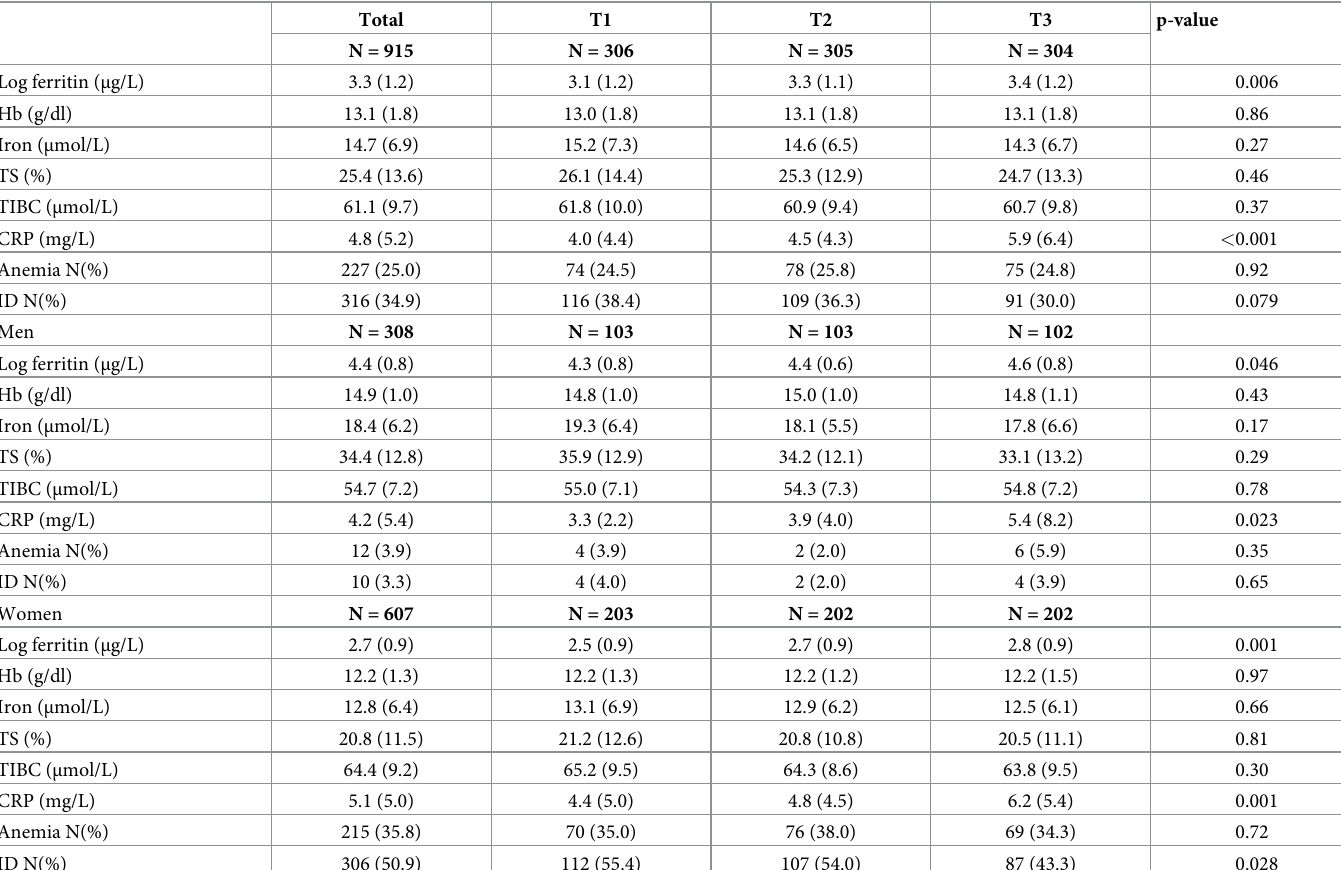
Table 3. Comparison of iron status indicators according to AF/GF ratio